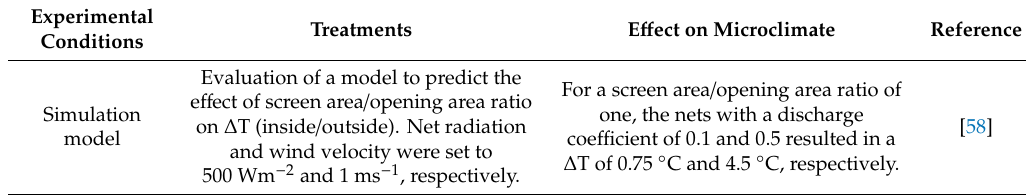
Table 2. Evaluation of anti-insect screens with di ff erent discharge coe ffi cients (C d ), porosity ( ε ), and mesh sizes on the temperature di ff erences ( ∆ T) and humidity between the inside and outside of the greenhouses under real conditions and with computational fluid dynamics (CFD) simulation